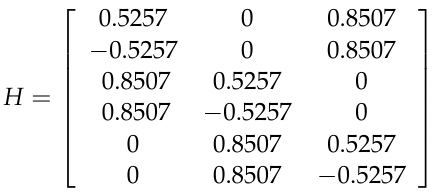
Figure 4. Residual vector values for Gyro 1–4 injection of 10 σ fault